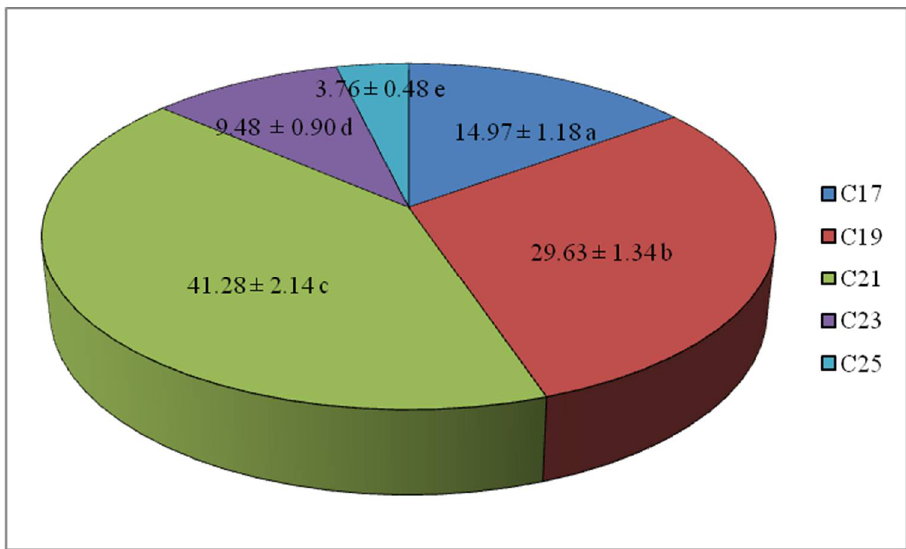
Figure 2. Percentage composition of 5- n -alk(en)yloresorcinol homologues of the wheat surface. Mean values expressing the percentage contents of alk(en)ylresorcinols ± SD were obtained from three independent experiments. Values followed by different letters are significantly different at p = 0.05 according to Tukey’s test. Table 4. The effect of wheat resorcinolic lipids on the radial growth of Rhizoctonia solani F93 myce- lium.